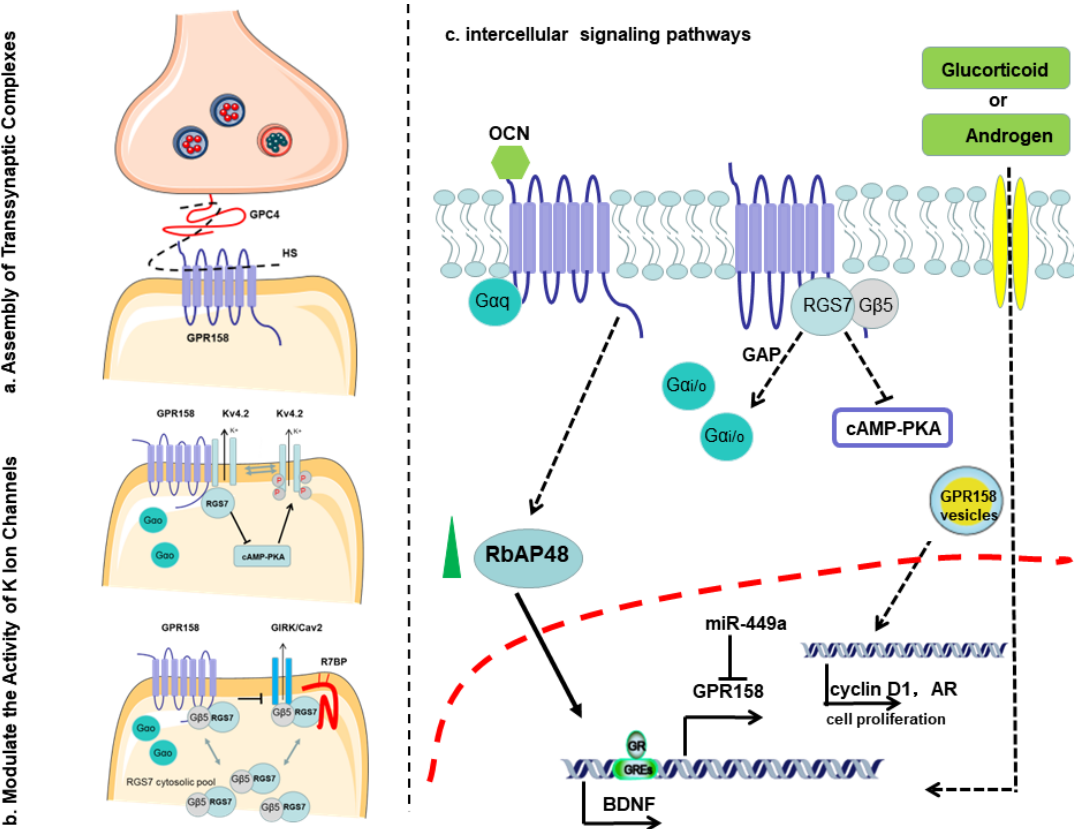
Figure 5. Roles of GPR158 in synaptic organization, ion permeability and signaling pathway media- tion. ( a ) Presynaptic GPR158 can interact with presynaptic GPC4 to form a GPR158–GPC4 complex and organize the formation of synapse. ( b ) GPR158 can recruit RGS7 to form a GPR158–RGS7 com- plex, regulate cAMP concentration and further modulate the K + and Ca 2+ ion channel. ( c ) OCN are proposed to activate GPR158 and increase the RbAP48 level, thus affect BDNF and GPR158 level, while some hormones, including glucorticoid and androgen, can affect the transcription of GPR158. OCN, osteocalcin; GPC4, glypican 4; RGS7, regulator of G protein signaling 7; cAMP, cyclic adenosine monophosphate. Arrows indicate increased expression and blunt head means